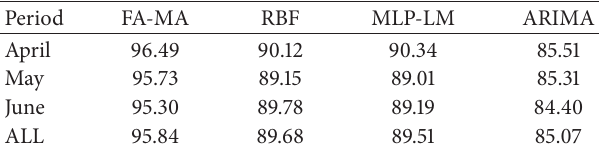
Table 9: DS of four forecasting